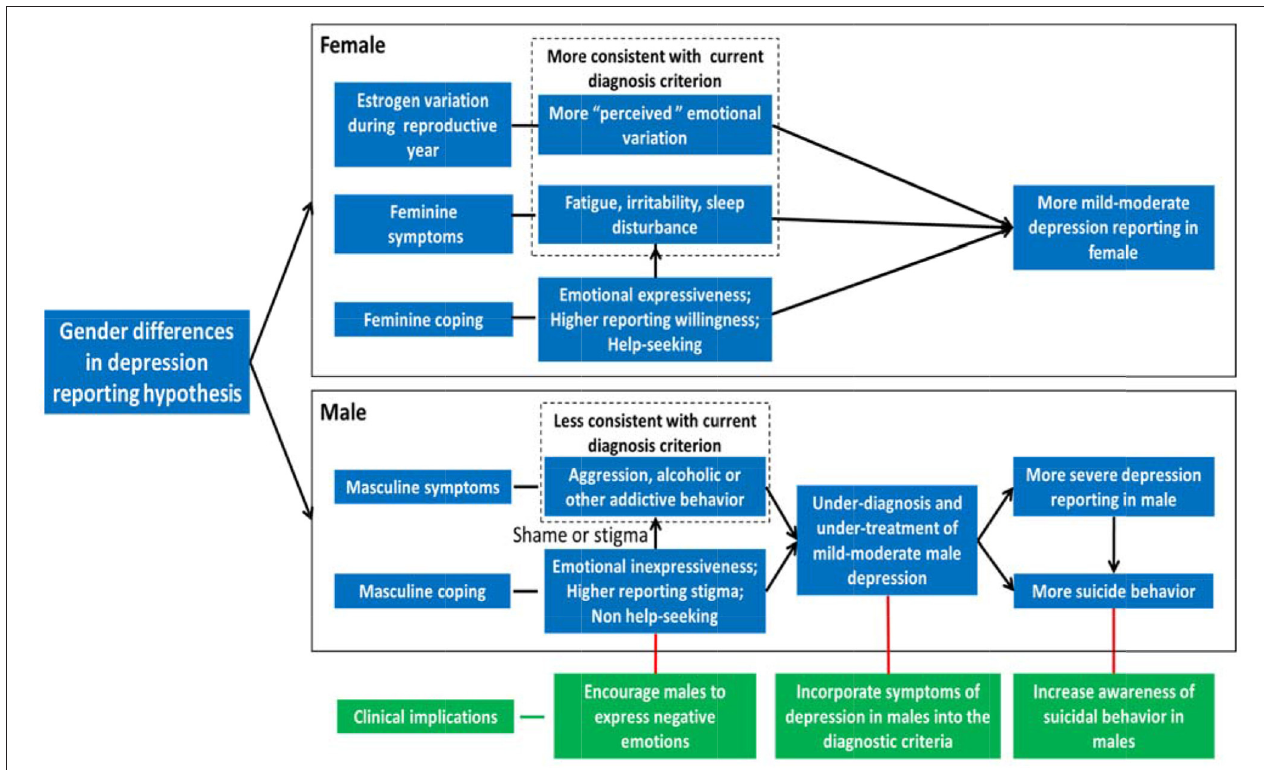
FIGURE 1 | Gender differences in self-reporting symptom of depression hypothesis. For females, estrogen variation during the reproductive year in female leads to more “perceived” emotional variation in the woman. Meanwhile, feminine coping styles (e.g., help-seeking and emotional expressiveness) and social expectations for females lead to traditional female depressive symptoms (e.g., fatigue, irritability, and sleep disturbance), which are more consistent with the current diagnosis criterion of depression. As a result, more mild-moderate depression is diagnosed in females. For males, masculine coping style (e.g., non-help-seeking and emotional inexpressiveness) and social expectation for males lead to more shame or stigma to express depression, results in traditional male depressive symptoms (e.g., aggression, alcohol, or substance abuse), which are less consistent with current diagnosis criterion of depression. As a result, mild-moderate male depression is under-diagnosed and under-treated, which leads to more severe depression and higher suicide reporting in males, and needs immediate attention. To diagnose and treat male depression early and effectively, it is critical to incorporate symptoms of depression in males into the relevant diagnostic criteria, encourage males to express negative emotions, and increase awareness of suicidal behavior in